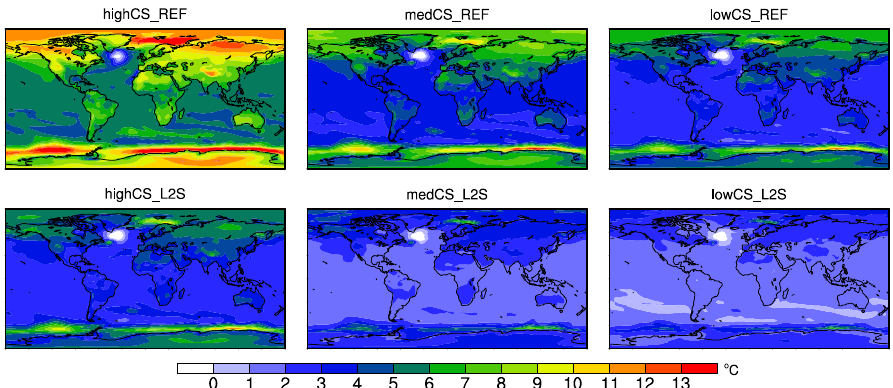
Fig. 15. Changes in annual mean surface air temperature ( ◦ C) for the period 2081–2100 relative to 1981–2000 for the five-member ensemble means of the IGSM-CAM simulations.